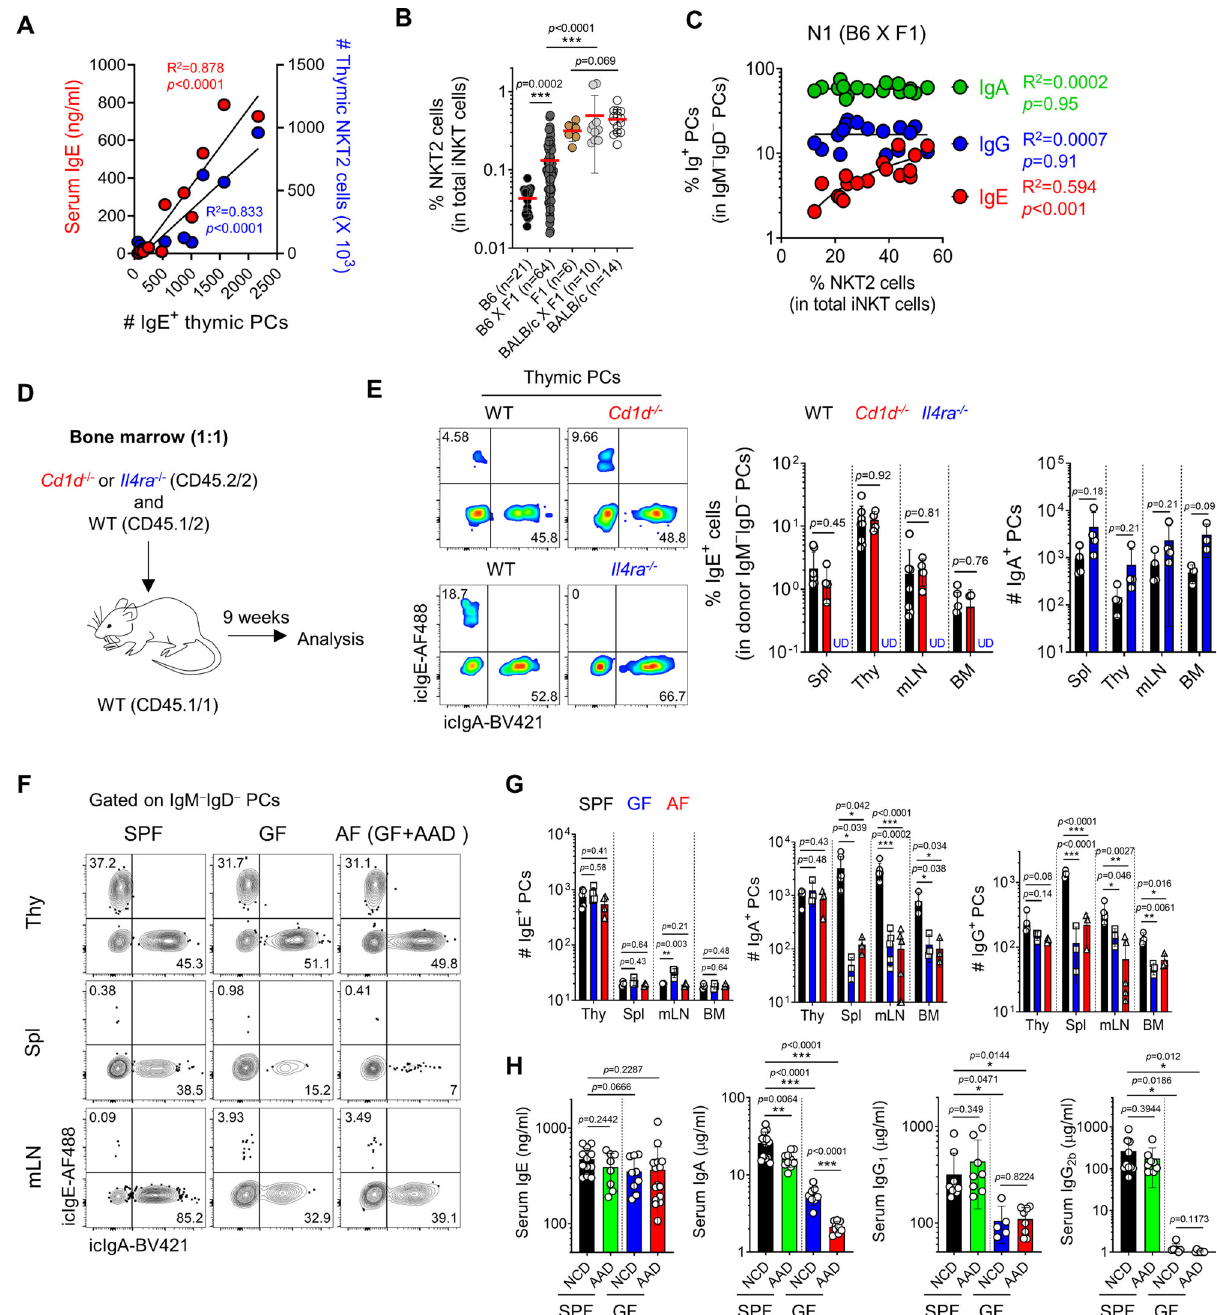
Fig. 2 iNKT cells regulate the development of IgE + thymic PCs. A A total of 1 – 8-week-old BALB/c mice were analyzed for their serum IgE concentrations by ELISA and the numbers of thymic NKT2 and IgE + PCs. Graph shows their correlations. B Graph shows frequencies of NKT2 cells among total iNKT cells in indicated mice. C Graph shows a correlation between frequencies of thymic NKT2 cells and PCs ( N = 17) from F1 X B6 mice. D Schematic of an experimental strategy of mixed BM chimera. E Total thymocytes from BM chimera generated as in ( D ) were enriched for CD138 + cells by MACS. Representative plots show IgE + thymic PCs derived from WT and Cd1d − / − (upper) or Il4ra − / − (lower) donors. Graph shows statistical analysis ( N = 4 – 8). F – H SPF or GF BALB/c mice were fed with either NCD or AAD and analyzed for thymic PC development ( N = 3 – 6). Representative FACS plots show icIgE, and icIgA expression of PCs in indicated tissues ( F ), and graphs show statistical analysis ( G ). Serum IgE, IgA, IgG 1 , IgG 2b concentrations of indicated BALB/ c mice were measured by ELISA ( N = 8 – 15) ( H ). Results are from two independent experiments. Numbers indicate the frequencies of cells in each quadrant. Data are presented as mean values± SD ( B , E , G , and H ). Each dot represents an individual mouse. Unpaired two-tailed t -tests were used. *** p < 0.001, ** p < 0.01, * p < 0.05. Not signi fi cant ( p > 0.05). Linear regression was used to calculate goodness of fi t (R 2 ) and P values. PC Plasma cell; SPF Speci fi c pathogen-free; GF Germ-free; AF Antigen-free; Thy Thymus; Spl Spleen; mLN Mesenteric lymph node; BM Bone marrow; NCD Normal chow diet; AAD Amino-acid diet; U.D. Undetected.